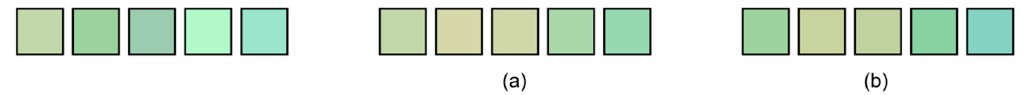
Figure 10. OSM greens’ color scheme (left) and suggested color schemes: ( a ) greens with Saturation 20, Brightness 84; ( b ) greens with Saturation 24, Brightness 84.